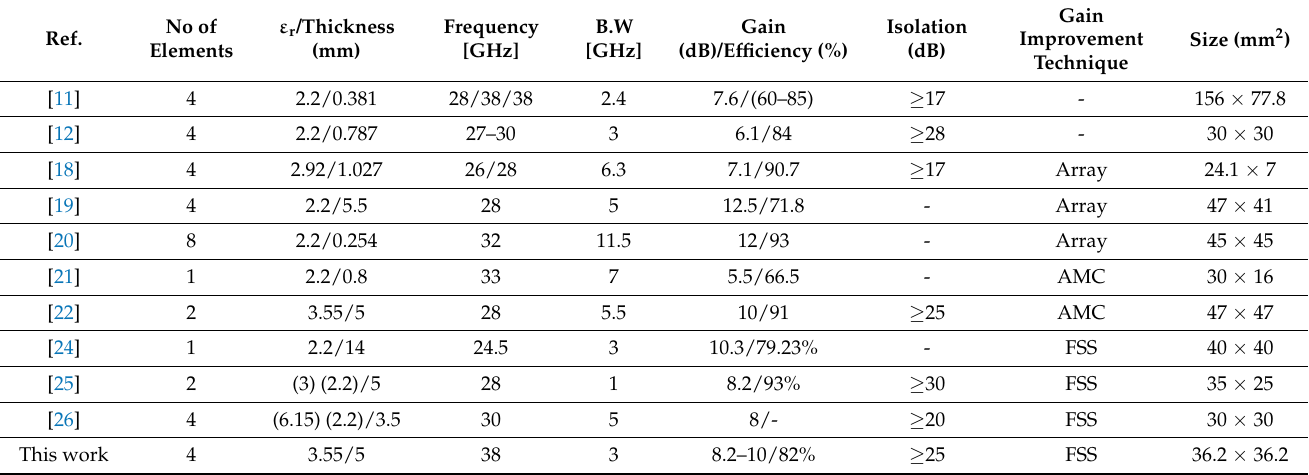
Table 1. The suggested antennas vs other designs.